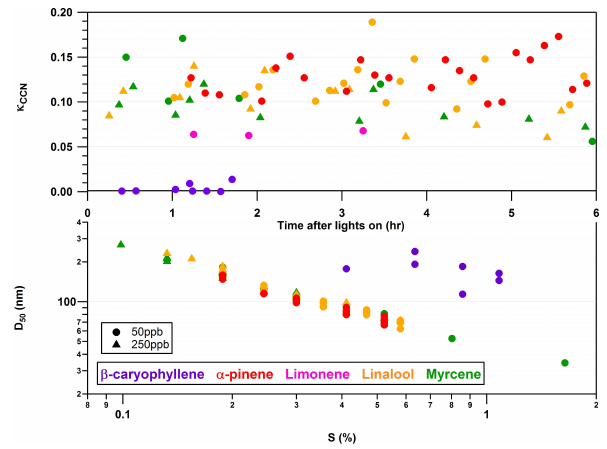
Fig. 7. Temporal profiles of CCN activity ( κ CCN ) of the SOA par- ticles from the five studied biogenic precursors (top panel). The re- lationship between the size at which 50% of the particles activated ( D 50 ) and supersaturation for all of the SOA systems is shown in the bottom panel.